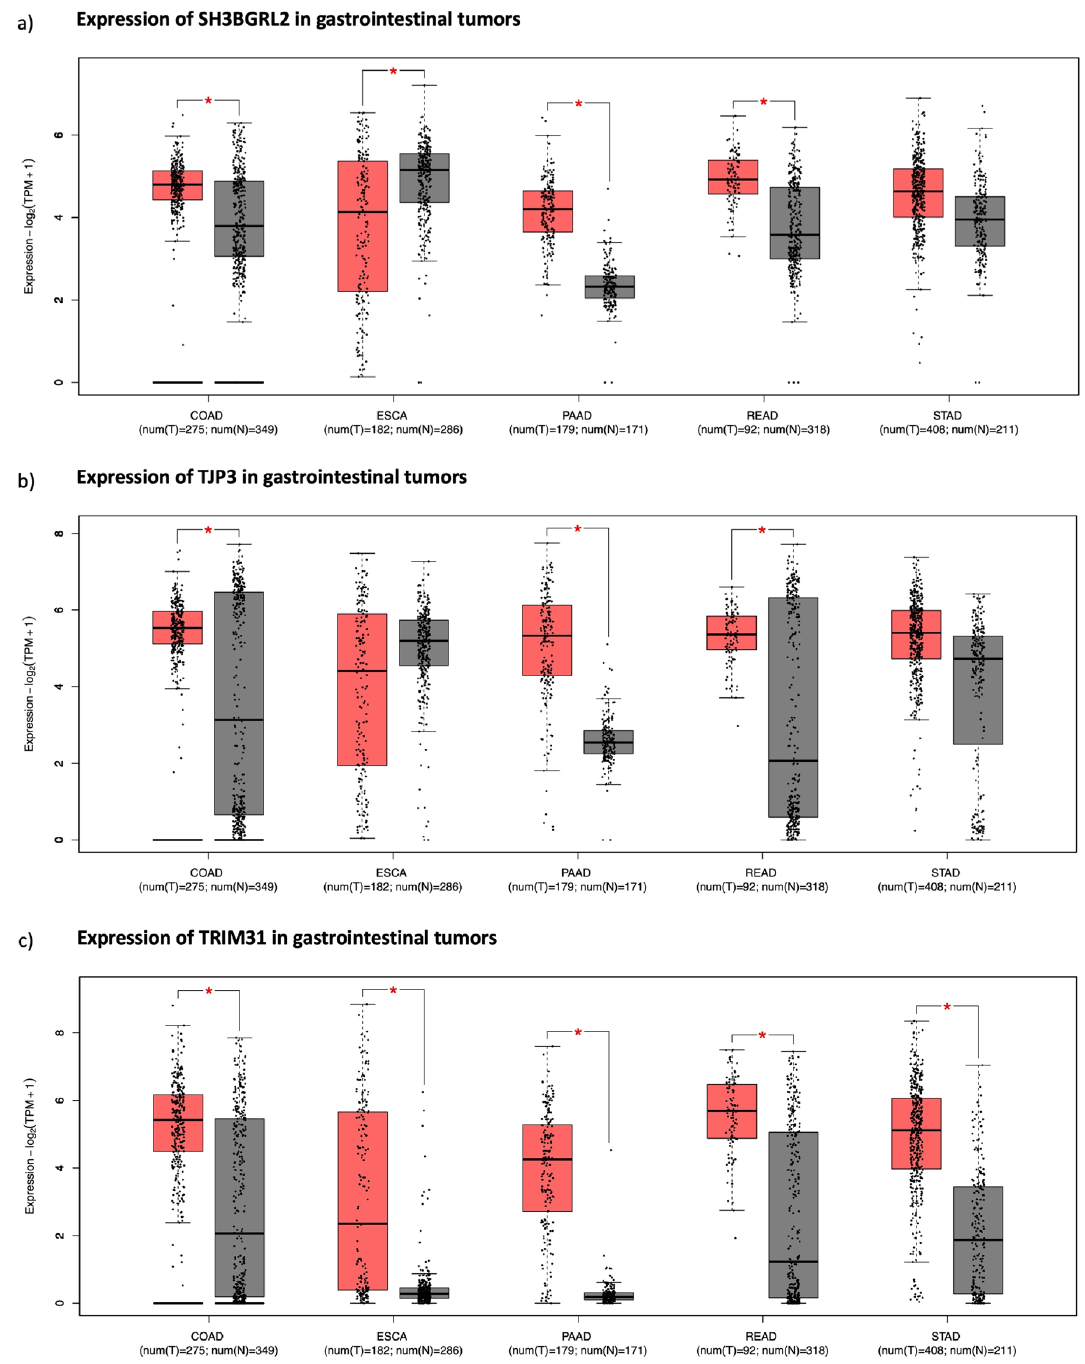
Figure 4. Cancer type-wise expression of eight genes ( a ; SH3BGRL2 , b ; TJP3, c ; TRIM31 ) in TCGA gastrointestinal solid tumor samples. Red boxes are tumor samples while gray ones are normal and boxplots with ‘*’ sign shows statistically significant differential gene expression value, p-value < 0.05. Gene Expression Profiling Interactive Analysis: colon adenocarcinoma (COAD), rectal adenocarcinoma (READ), esophagus adenocarcinoma (ESCA), pancreas adenocarcinoma (PAAD), stomach adenocarcinoma